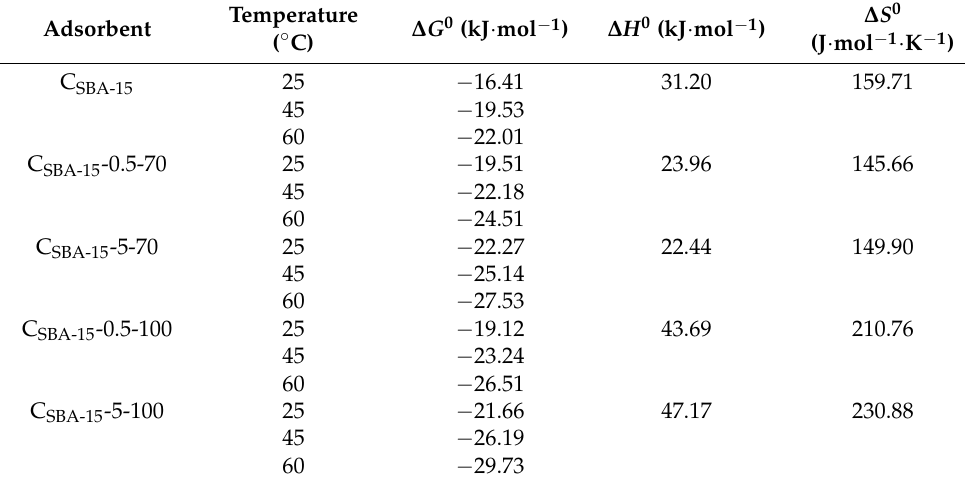
Table 4. Thermodynamic parameters obtained.